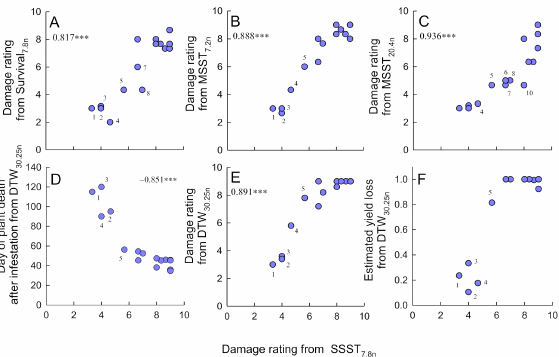
Figure 3. Bi-plots of SSST 7.8n damage ratings (x-axes) against damage ratings from ( A ) the Survival 7.8n , ( B ) MSST 7.2n , and ( C ) MSST 20.4n tests. Bi-plots of SSST 7.8n damage ratings against